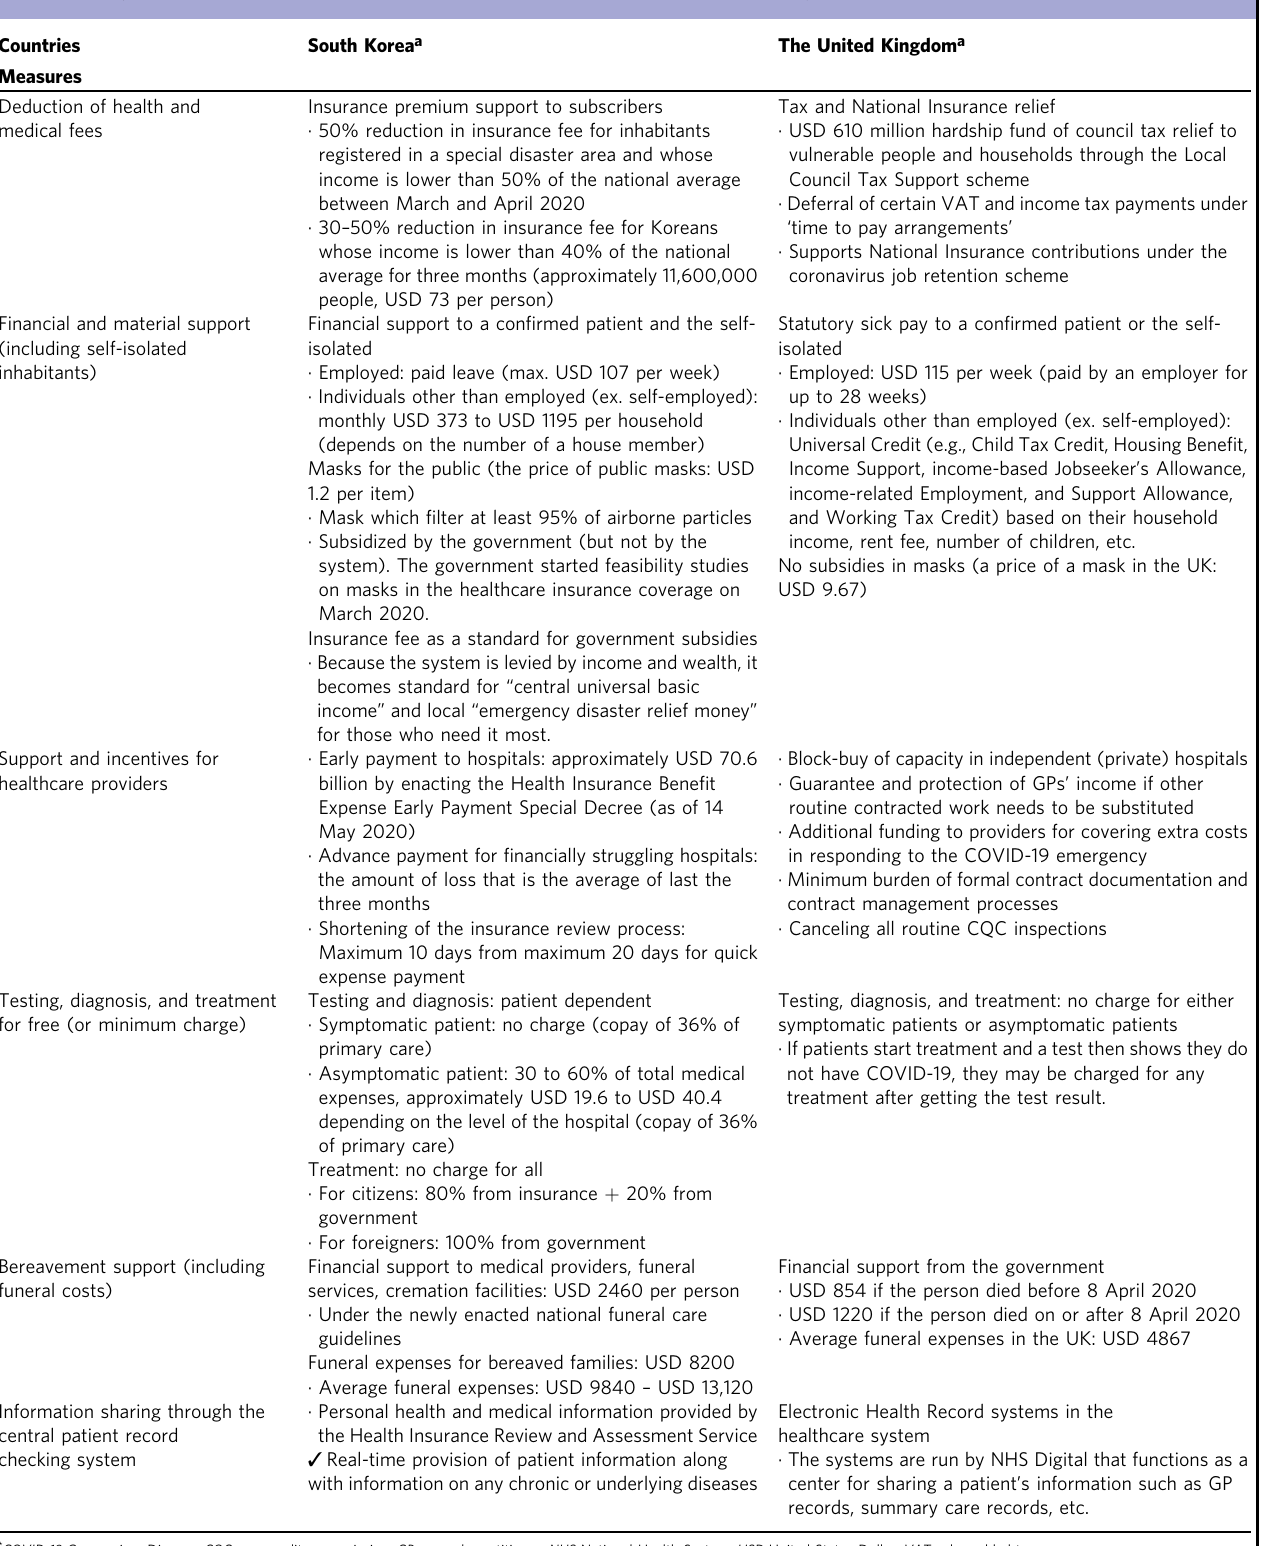
Table 2 Comparison of Healthcare Measures in South Korea and the UK in tackling COVID-19.